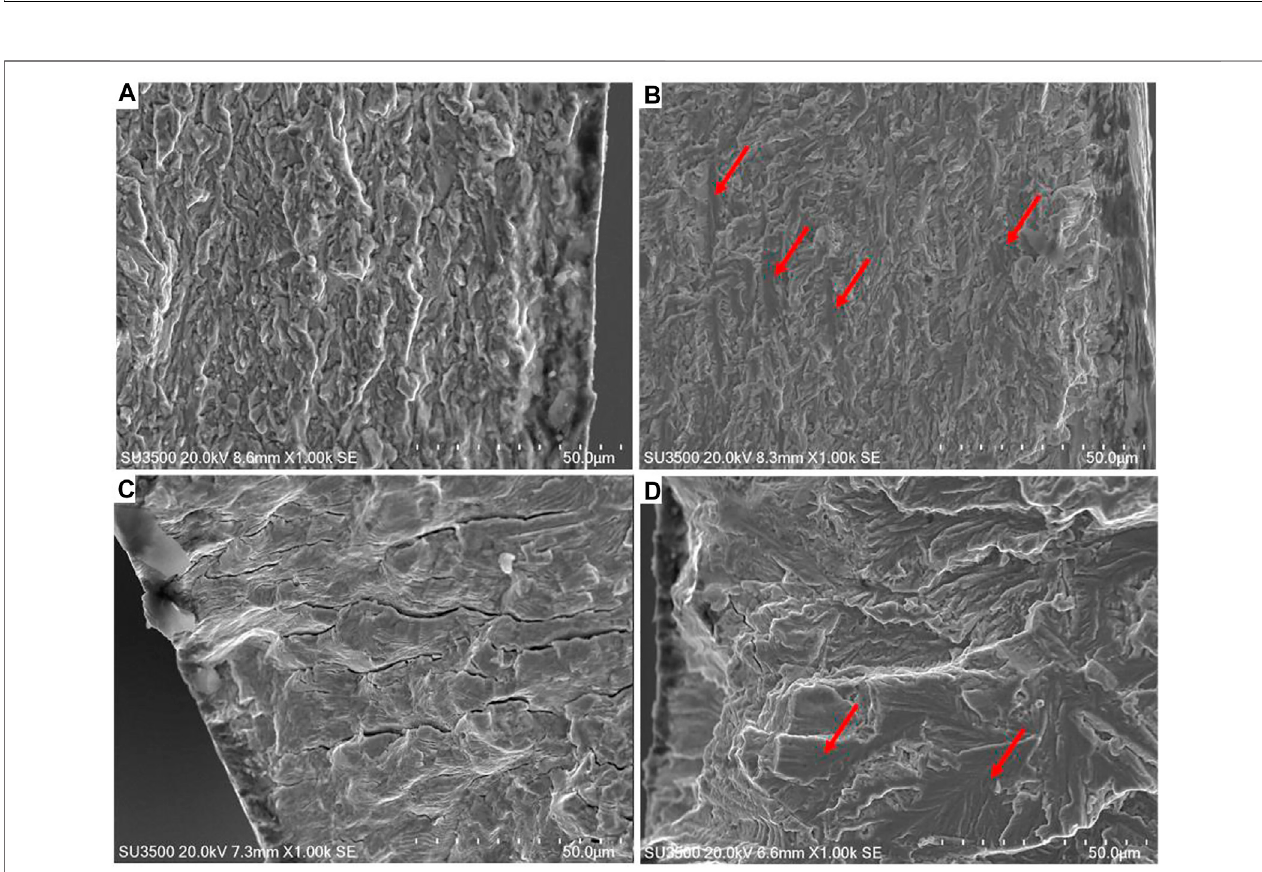
FIGURE12| SEMobservationsofthefracturesurfacesafterfatiguetestinginseawaterat (A,C) OCPand (B,D) underCPfor (A,B) non-weldedsamplesand (C,D) samples with an orbital weld. Brittle areas are indicated by red arrows.